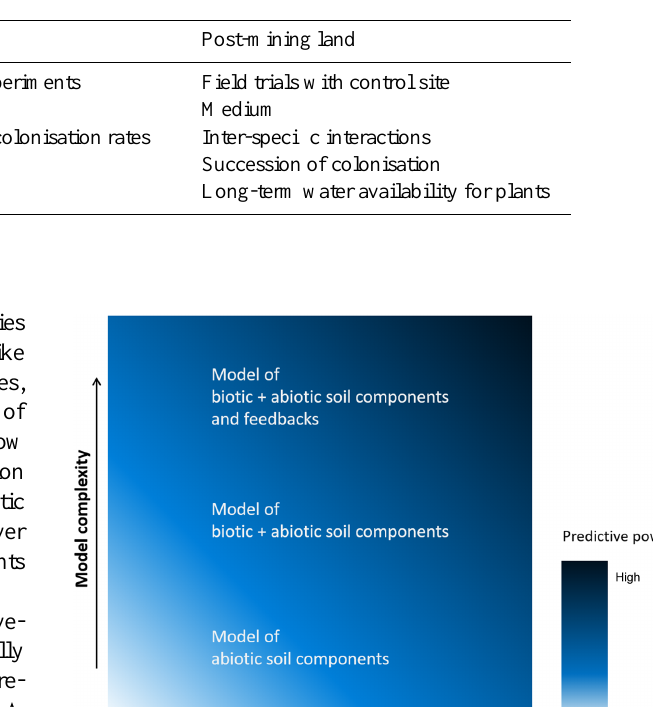
Table 1. Proposed approaches to collect empirical data in relation to ant–soil interactions.